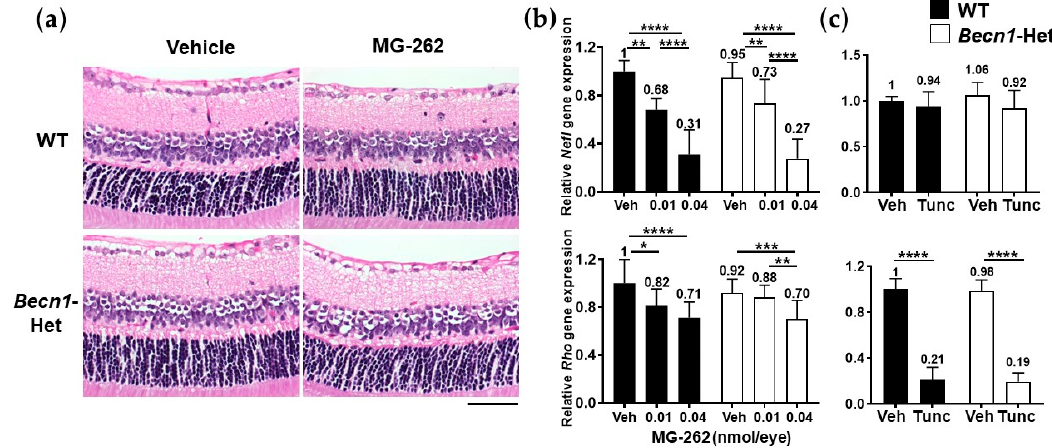
Figure 3. Beclin1-heterozygous mice ( Becn1 -Het) and wild-type (WT) mice are equally sensitive to retinal degeneration, induced by proteasome inhibition and endoplasmic reticulum (ER) stress. Chemicals, or their vehicle, were intravitreally injected into the eyes of WT and Becn1 -Het mice, and eyes were isolated 7 and 4 days post-injection for histological evaluation ( a ) and gene expression analysis ( b , c ), respectively. Quantitative PCR was performed for neurofilament light chain ( Nefl ) and rhodopsin ( Rho ) genes. Each expression value was normalized to glyceraldehyde-3-phosphate dehydrogenase ( Gapdh) , the housekeeping gene, in individual samples and is shown relative to that obtained in the WT vehicle group. ( a ) Representative images of hematoxylin and eosin-stained retinae, following intravitreal injection of 0.01 nmol/eye MG-262 or its vehicle (10% dimethyl sulfoxide or DMSO in Dulbecco’s phosphate buffered solution or D-PBS). The scale bar shows 50 µm. ( b ) Effects of MG-262 (0.01 and 0.04 nmol/eye) or its vehicle (Veh, 10% DMSO in D-PBS) on Nefl and Rho gene expression levels in the retina. N = 8 to 16 eyes from 4 to 8 mice per each group. Black and while bars show WT and Becn1 -Het, respectively. ( c ) Effects of tunicamycin (Tunc, 2.5 µg/eye) or its vehicle (Veh, 25% DMSO in D-PBS) on Nefl and Rho gene expression levels in the retina. N = 5 to 8 eyes from 4 mice per each group. Each value represents the mean ± standard deviation with the mean value indicated at the top of each bar. For statistical analysis, a two-way analysis of variance was performed, followed by Sidak’s post hoc test. * p < 0.05, ** p < 0.01, *** p < 0.001, **** p < 0.0001 for each pair of comparison.